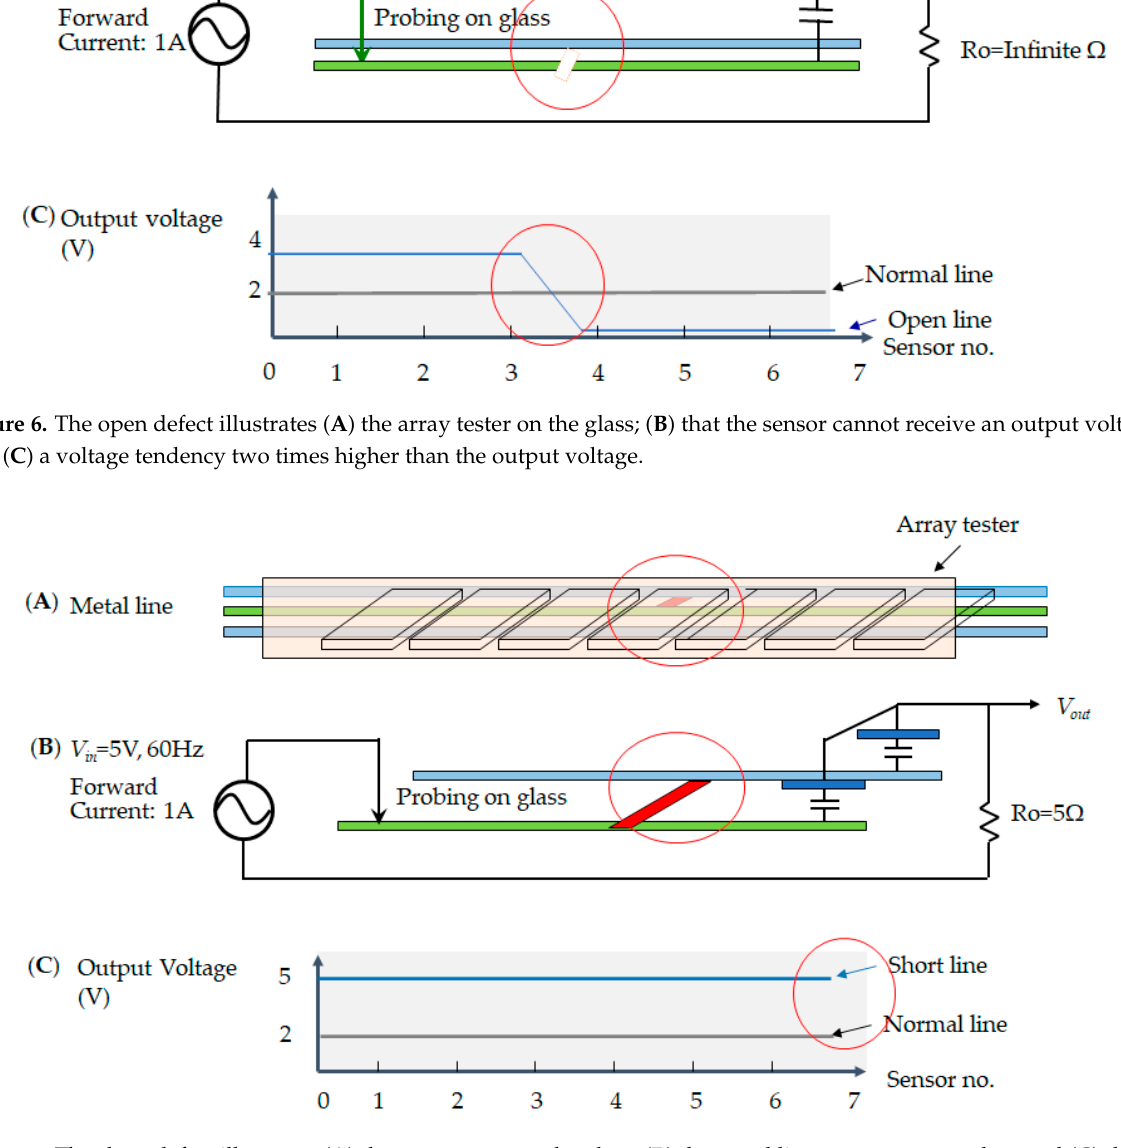
Figure 7. The short defect illustrates ( A ) the array tester on the glass; ( B ) the metal lines across one another; and ( C ) the at output voltage is two times higher than in the normal line.